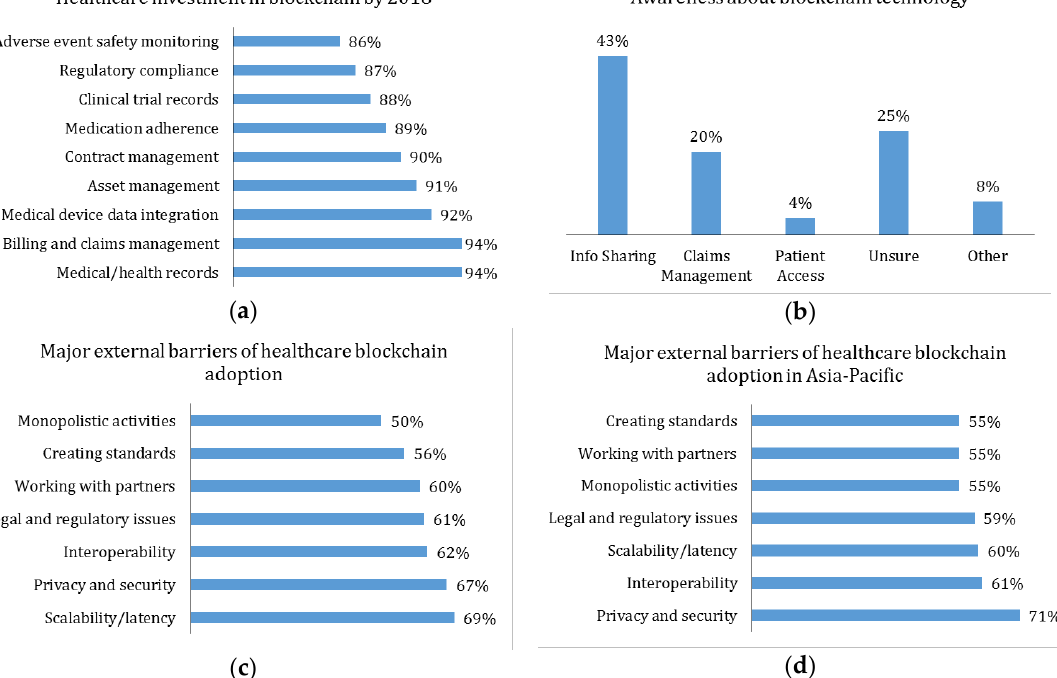
Figure 1. The potential of blockchain-based solution and major external barriers of adoption in the healthcare industry: ( a ) Healthcare investment in blockchain by 2018 [9]. ( b ) Awareness about blockchain technology among medical practice administrators and executives [10]. Major external barriers of healthcare blockchain adoption in ( c ) the world [11] and ( d ) Asia-Pacific [12], answered by respondents.